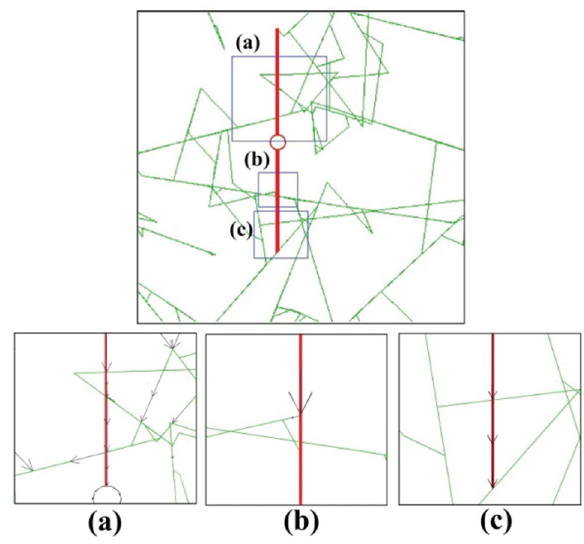
Fig. 17 Fluid flow conditions in sections of hydraulic fractures of 10 and 12 m in length